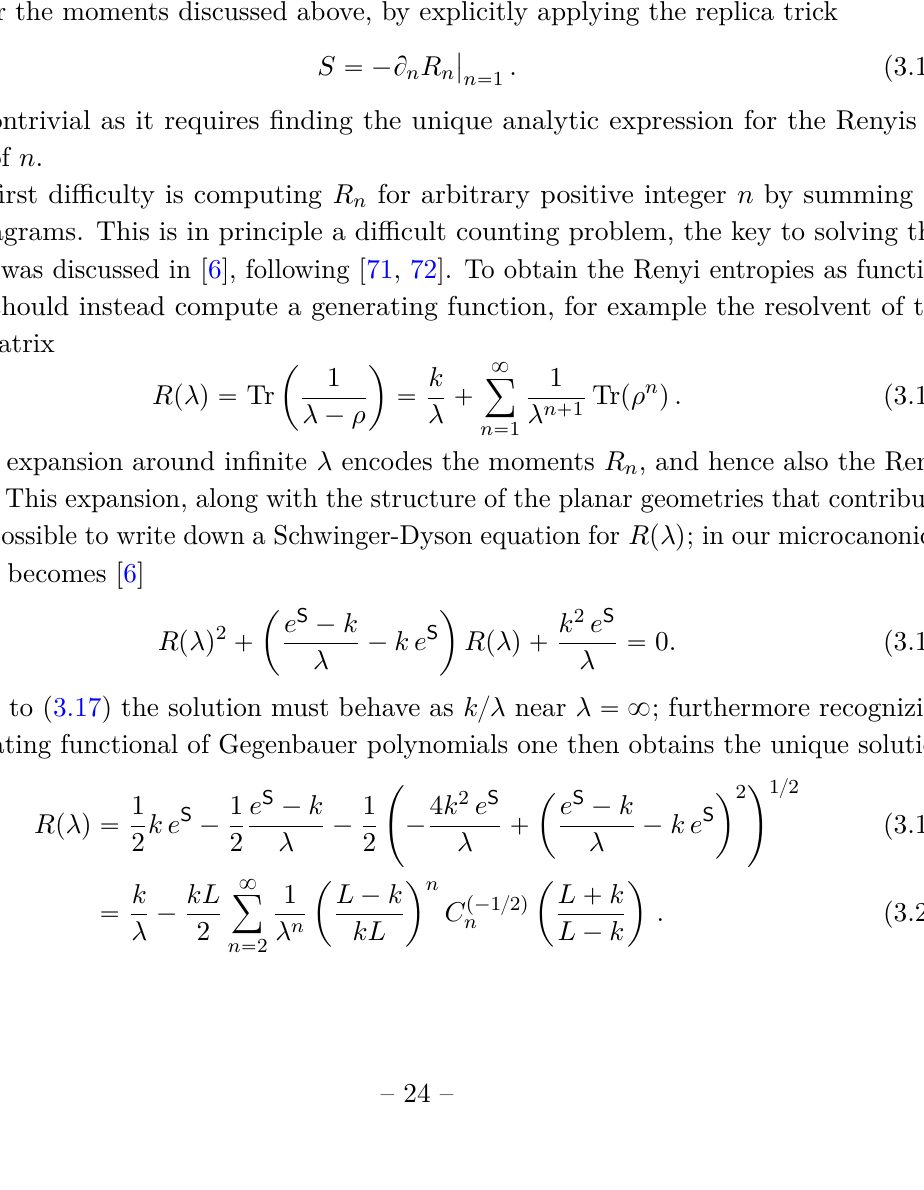
Figure 6 . Entropy S as function of k with e S approximation (3.25)